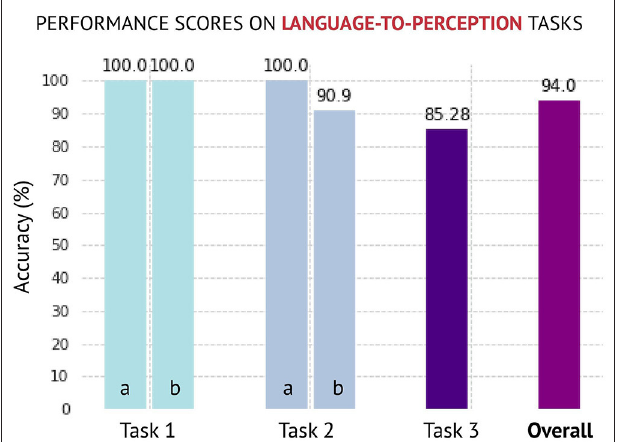
FIGURE 8 | The performance (accuracy) scores obtained for perception tasks. The successful solving of tasks 1–3 highly depends on the model’s skill to learn new animals from images at runtime. The phrases acquired during the test stage are similar to those trained but involving the new animals. The system can generalise with an overall accuracy of 94% on novel elements of the animal class, which are not specified in the initial training of the system, without re-training in the whole